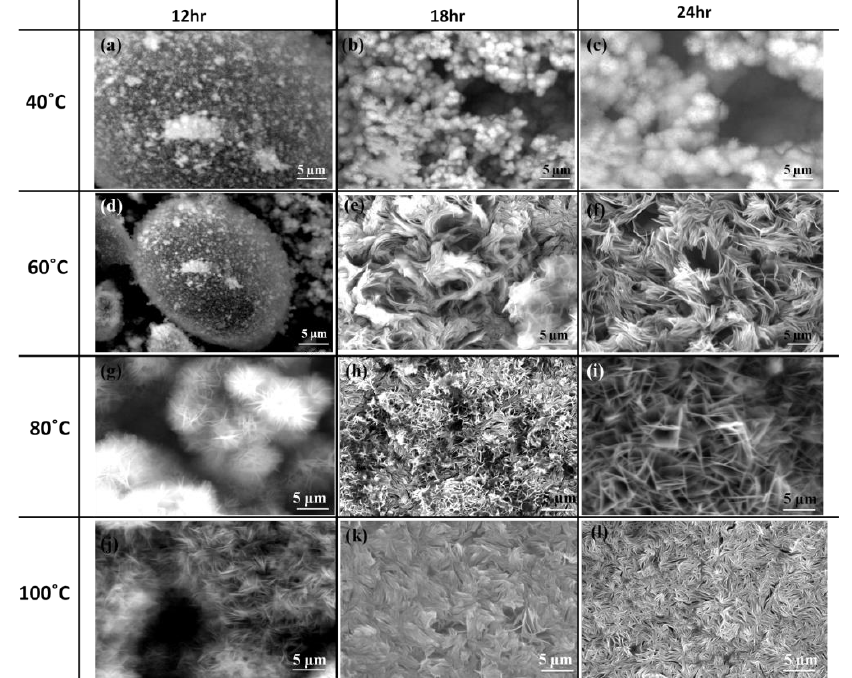
Figure 2. Effect of synthetic conditions on the growth of LDHs developed directly on the AA6082 substrate [40]: Evolution of the morphology by combining different temeratures (from 40 °C to 100 °C, vertical axis) and times (from 12 h to 24 h, horizontal axis). Image reproduced with permission from the publisher (MDPI).